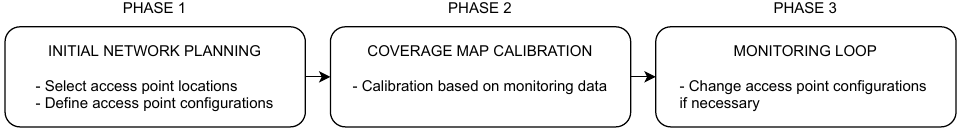
Figure 2. Different phases, from initial network-planning to the monitoring